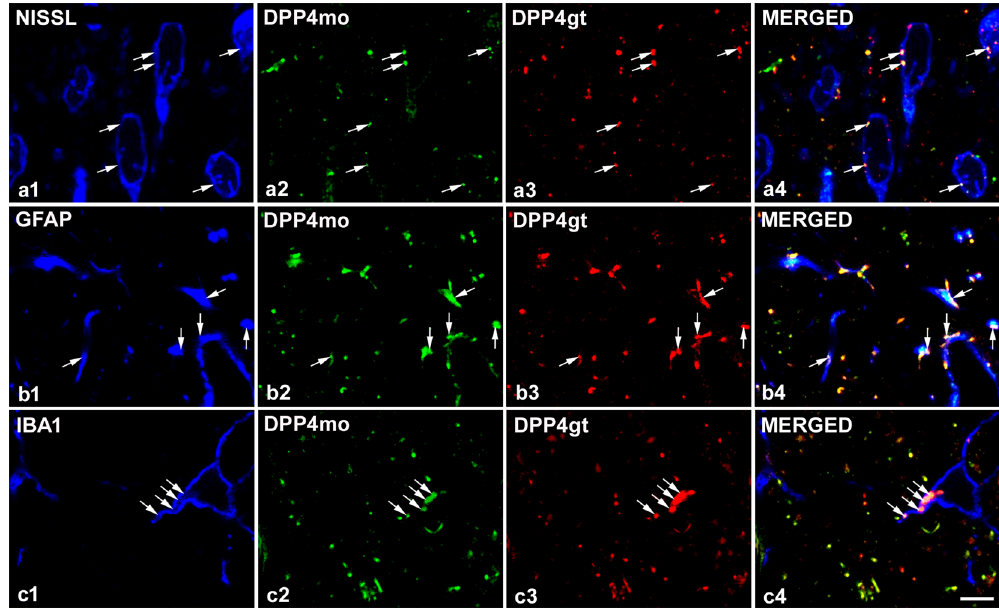
Figure 2. DPP4 immunoreactivity of different cell types in the spinal dorsal horn. DPP4-immunoreactive puncta appeared in Nissl stained neurons (row a), GFAP labelled astrocytes (row b) and IBA1 positive microglial cells (row c). Co-staining with mouse monoclonal antibody against the full length rat CD26 protein (DPP4mo, column 2) and polyclonal goat DPP4 antibody that was raised against the synthetic peptide C-PPHFDKSKKYP representing the internal region of DPP4 (DPP4gt, column 3) labelled the same puncta in all three cell types demonstrating the specificity of the two antibodies (arrows). All the images are single optical sections. Scalebar: 5 μ